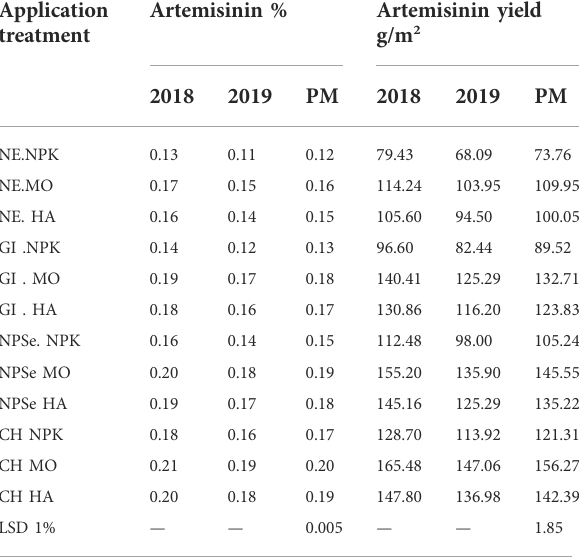
TABLE 2 ART % and artemisinin yield and their pooled means (PM) in response to CH, NSe, and GI elicitors under chitosan (CH) under (NPK), Moringa (MO and humic acid (HA)